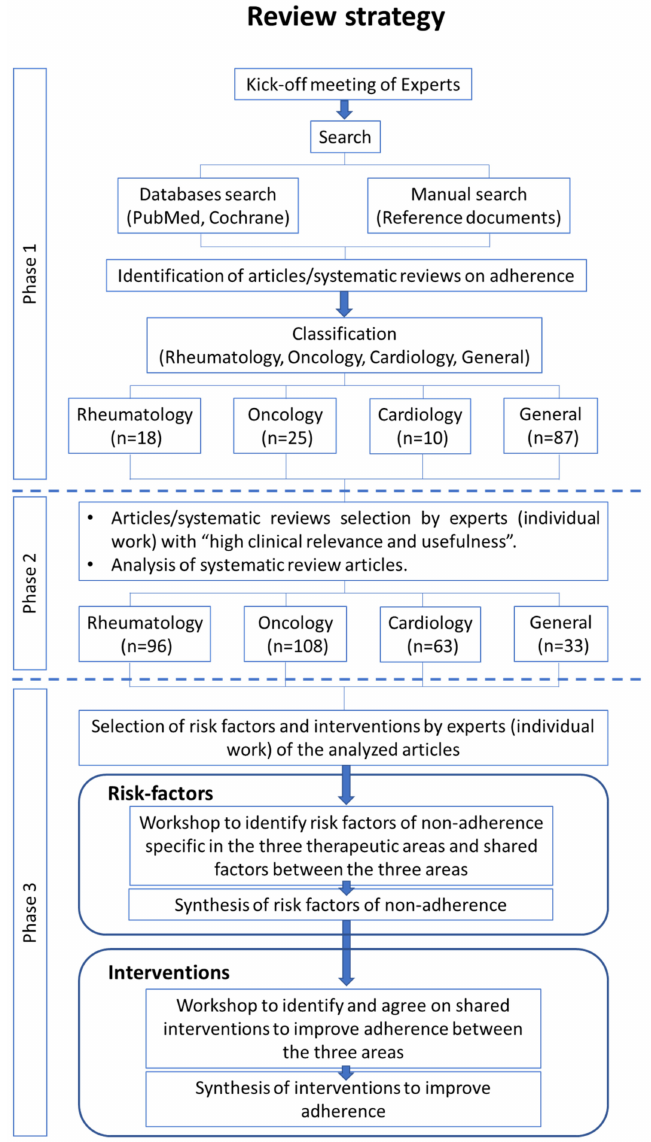
Figure 1. Study selection flow